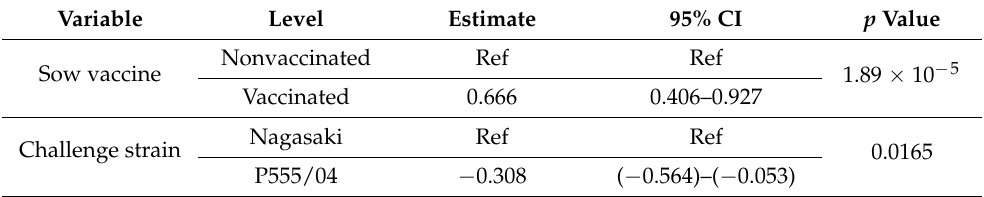
Figure 5. Levels of IgG against F4 in bronchoalveolar lavage fluid (BALF). Piglets born to vaccinated (VAC, pink and orange by biological sow) or nonvaccinated (NVAC, blue and green by biological sow) sows were challenged with G. parasuis at 22 days of life and 2 weeks later were euthanized. At that time, BALF samples were taken and F4 antibodies were measured by ELISA. The individual value for each piglet and the average absorbance in the ELISA (horizontal lines) are shown in the graph. Error bars are the standard deviation. Table 5. Final model with the association of log10 of the ratio of specific F4 IgG to total IgG in BALF and predictor variables using multivariable linear regression with repeat measurements while accounting for sow identity as random effect. BALF samples were taken from piglets after